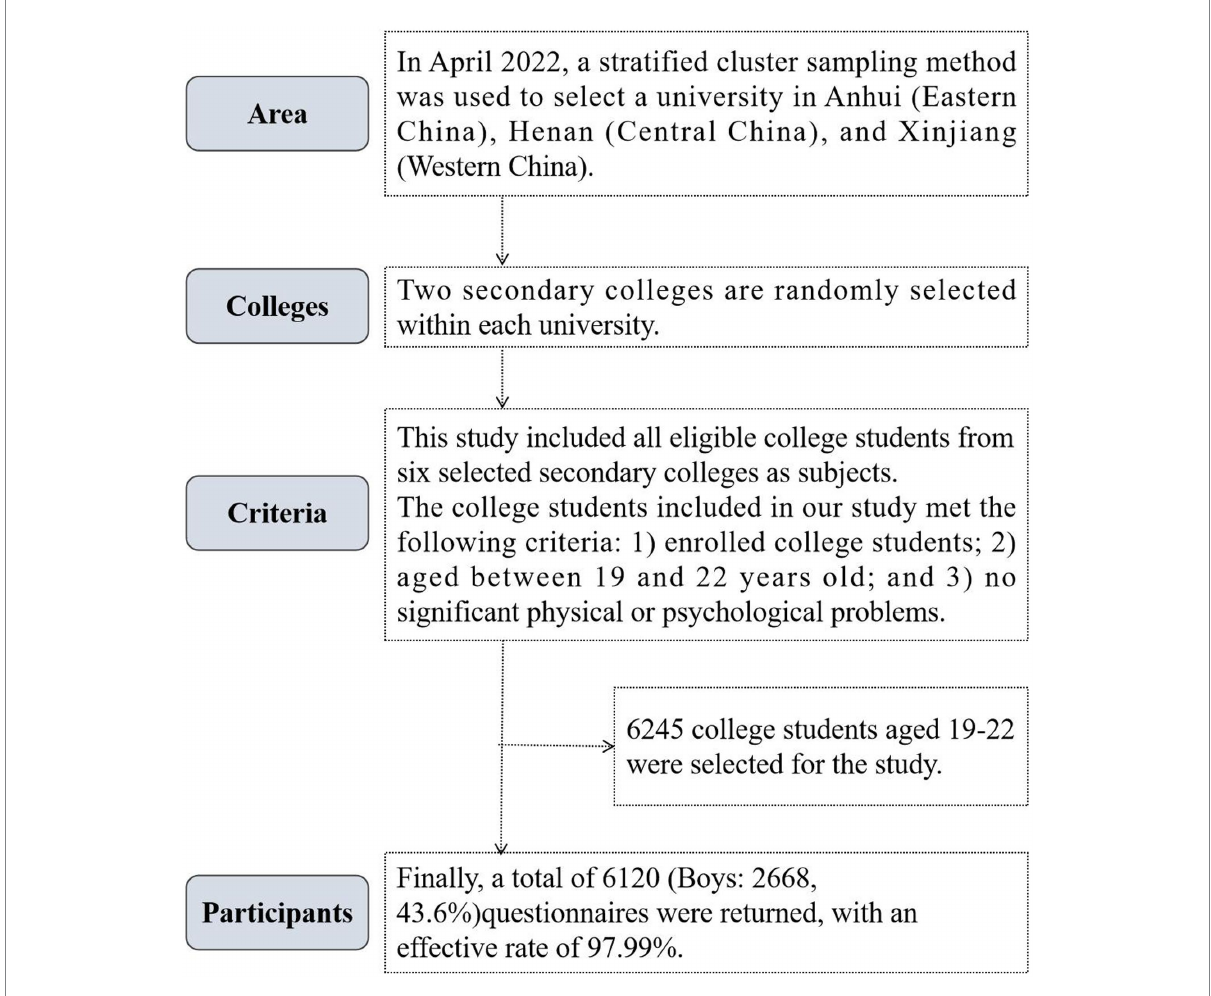
FIGURE 1 Sampling process of Chinese college students’